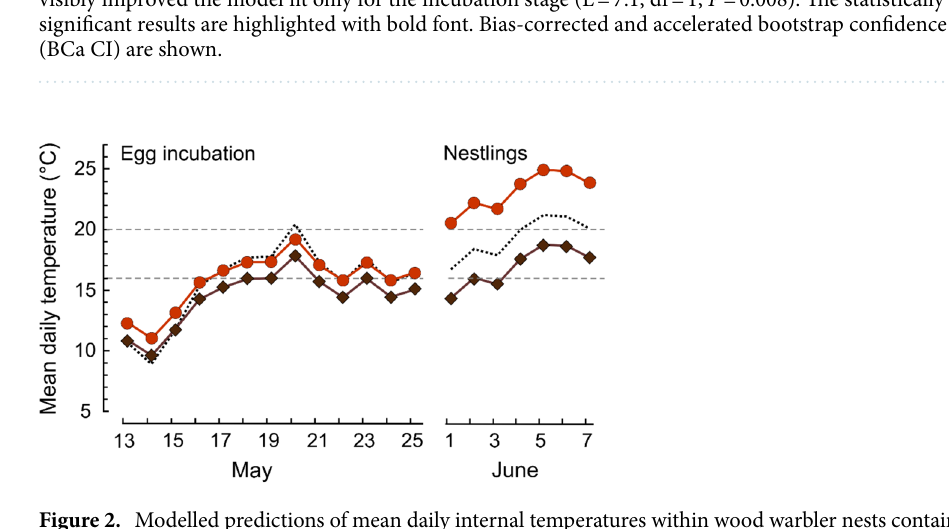
Figure 2. Modelled predictions of mean daily internal temperatures within wood warbler nests containing either incubated eggs or fully-feathered nestlings (red circle), and in Myrmica ant nests (brown diamond) at the same ambient temperatures (dotted line) recorded by the meteorological station in Białowieża village in 2019. Values shown are the ambient and predicted internal temperatures for the periods corresponding to the egg incubation (left) and the later nestling period (right) for the majority of wood warbler nests monitored in 2019. The two horizontal (dashed) lines mark the minimum temperature (16 °C) and lower threshold of the optimum temperature (20–25 °C) necessary for the development of Myrmica ant broods 33